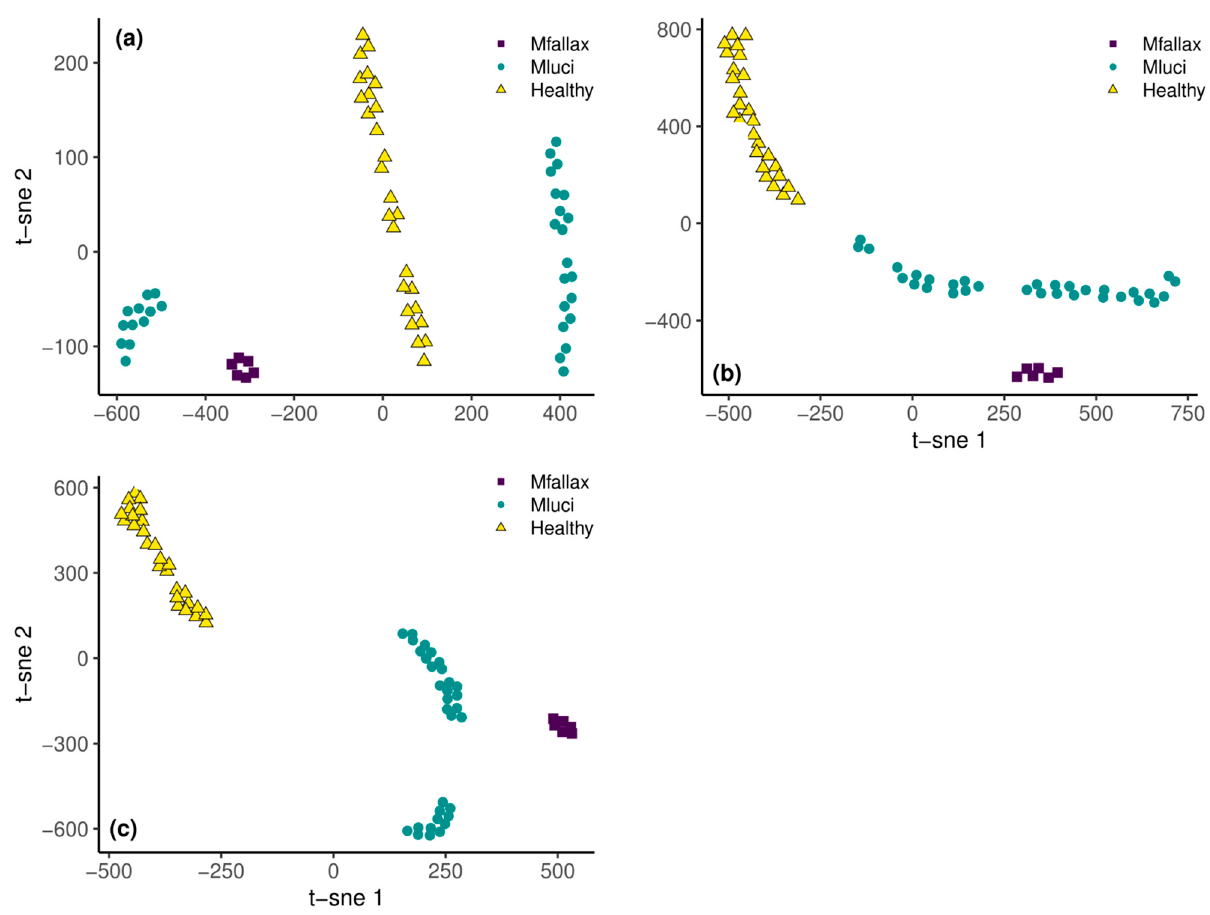
Figure 7. t-SNE scatter plots of Meloidogyne luci and M. fallax spectral derivative data: ( a ) internal data, ( b ) peels, ( c ) external data.